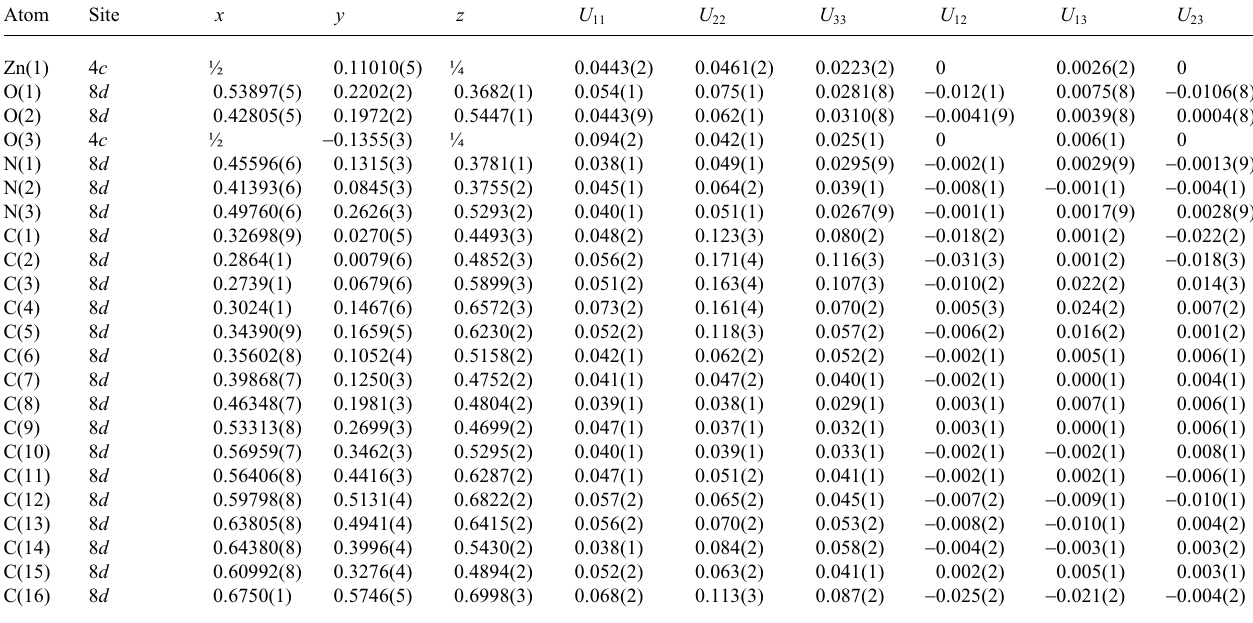
Table 3. Atomic coordinates and displacement parameters (in Å 2 )